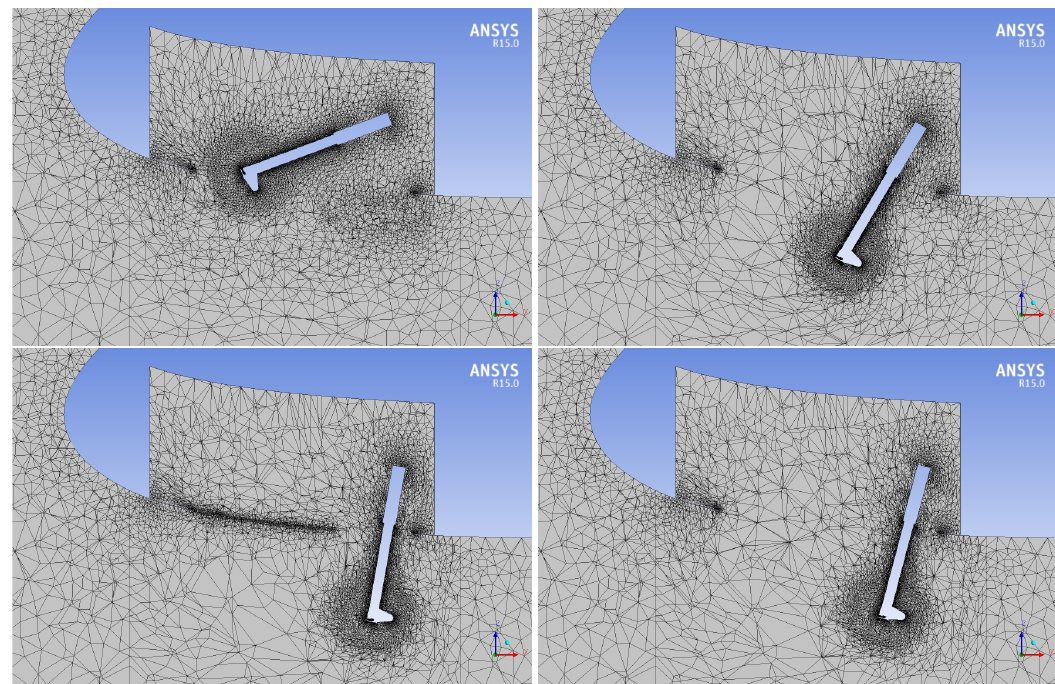
Figure 8. NLG: computational mesh during the lowering phase (clockwise).